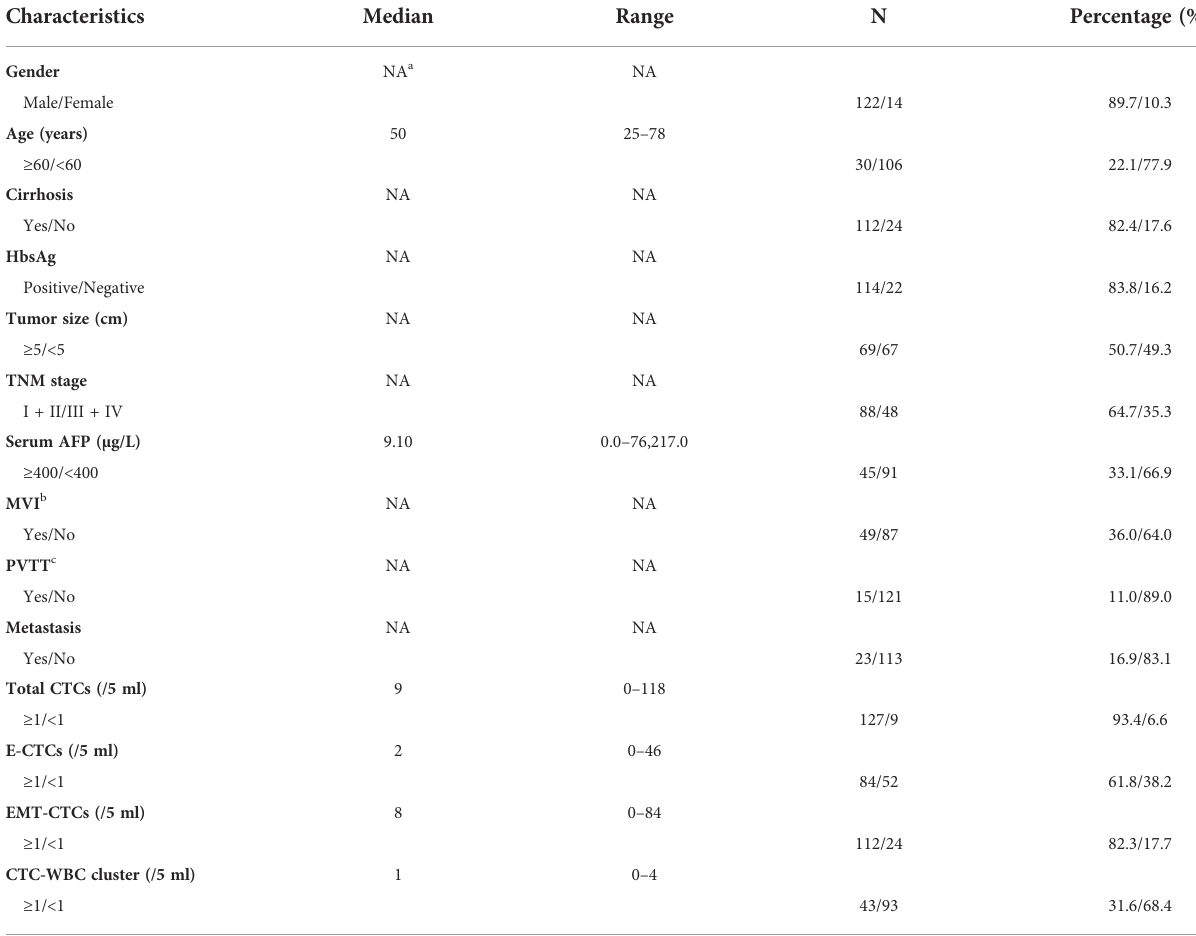
TABLE 1 Clinicopathological characteristics of 136 HCC